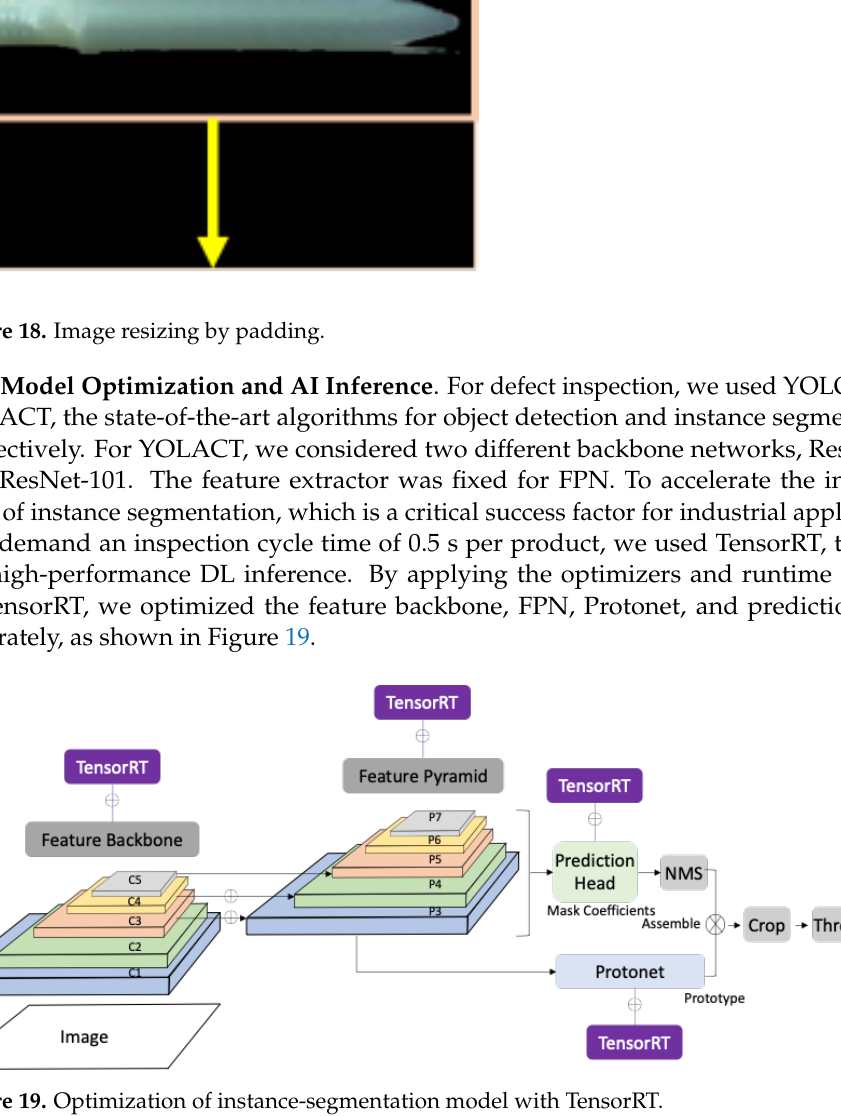
Figure 19. Optimization of instance-segmentation model with TensorRT. With the image segmentation model (YOLACT), we did not experience any unusual inspection errors as in the object-detection model (YOLOv4). However, the instance- segmentation model did now work well enough to meet the industrial requirement. The manufacturer wanted to detect defects whose diameter was bigger than 0.5 mm. precisely than in the trial test, whose results are presented in Figure